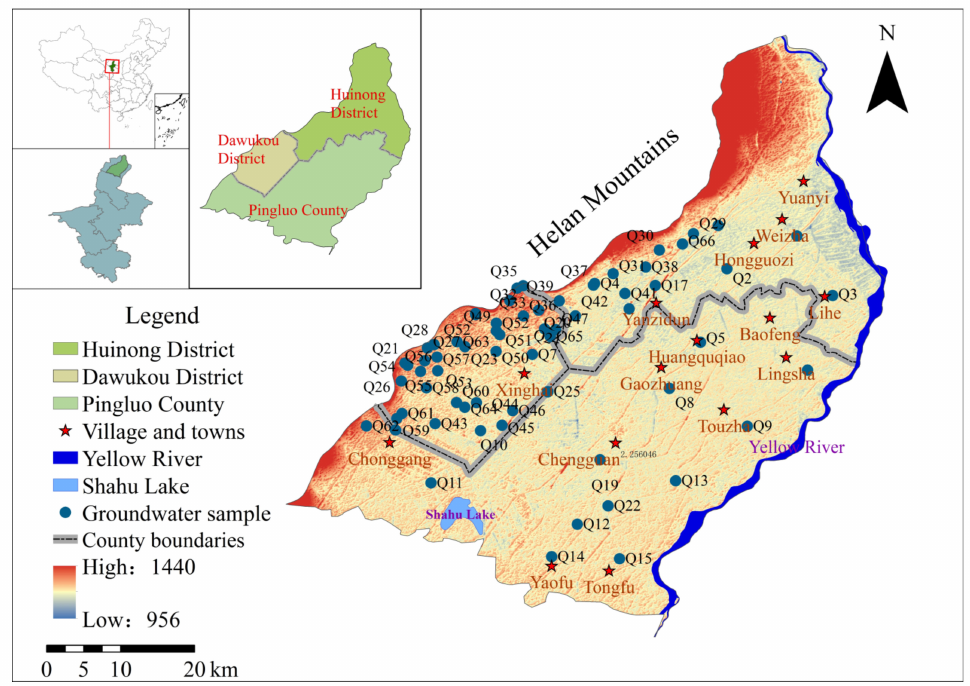
Figure 1. Groundwater sampling location of the Shizuishan